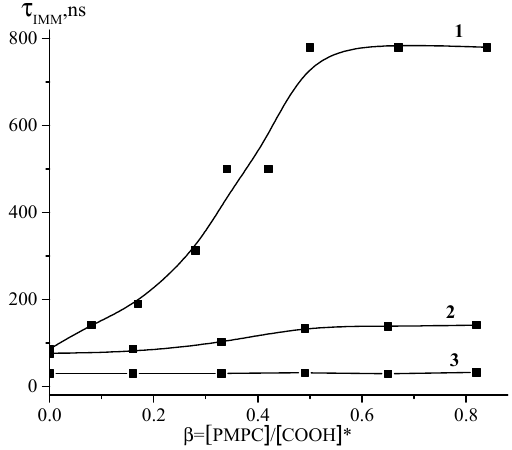
Figure 2. Dependences of τ IMM of PMAA* (1), copolymer (MAG-MAA 70 )* (2), copolymer (MAG-MAA30)* (3) on the ratio β = [PMPC]/[ СООН ].